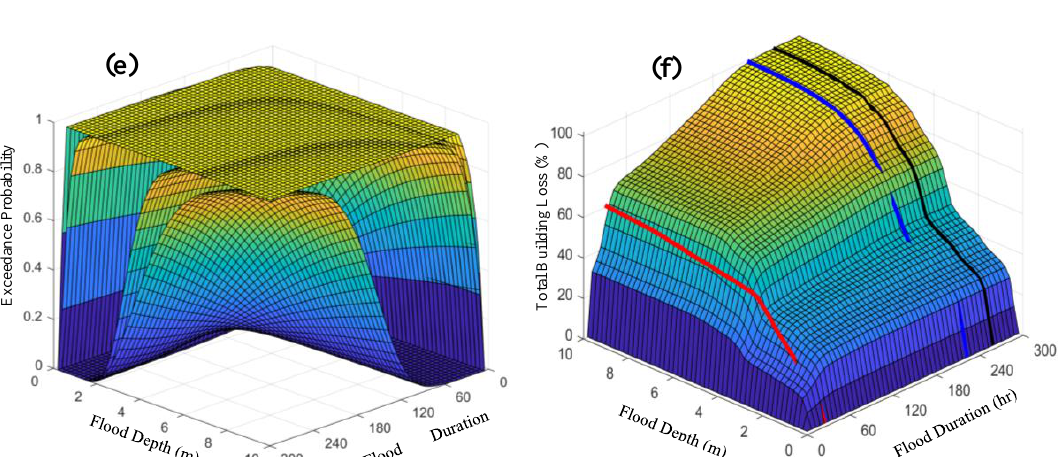
Figure A18. F4 archetype analysis results: ( a ) Component fragility curves; ( b ) Building fragility curves; ( c ) Selected components’ loss curves; ( d ) Building loss curves; ( e ) Building fragility surfaces; ( f ) Building loss surface.